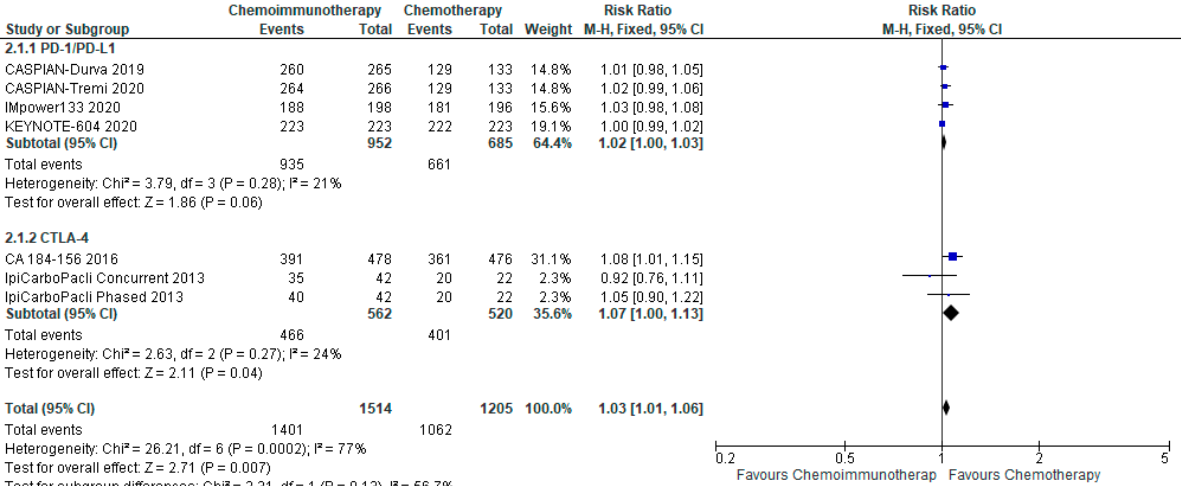
Figure 5. Forest plot of risk ratios for all grade adverse events in patients with ES-SCLC and treated with chemo-ICI versus standard chemotherapy. PD-1/PD-L1, programmed death (ligand)-1; CTLA-4, cytotoxic T-lymphocyte-associated protein 4; HR, hazard ratio; CI, confidence interval; M-H, Mantel–Haenszel.